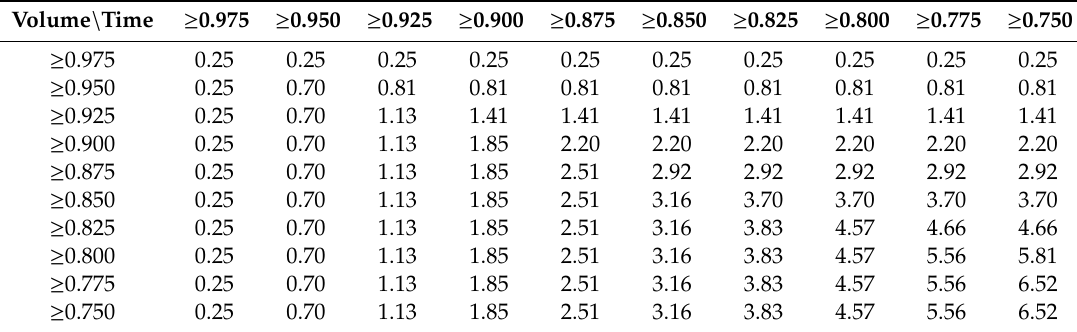
Table 5. The corresponding GSI of maximum water supply amount for the Shihmen reservoir. Volume \ Time